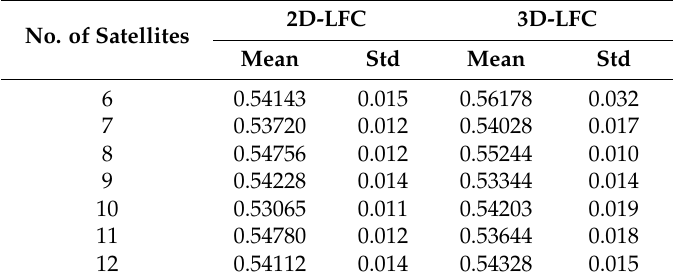
Table 6. The mean and the standard deviations of the COV values for 3 h-distributions of radio occultation events (ROEs) during one day for the optimal 2D-LFCs and 3D-LFCs composed of 6–12 satellites.